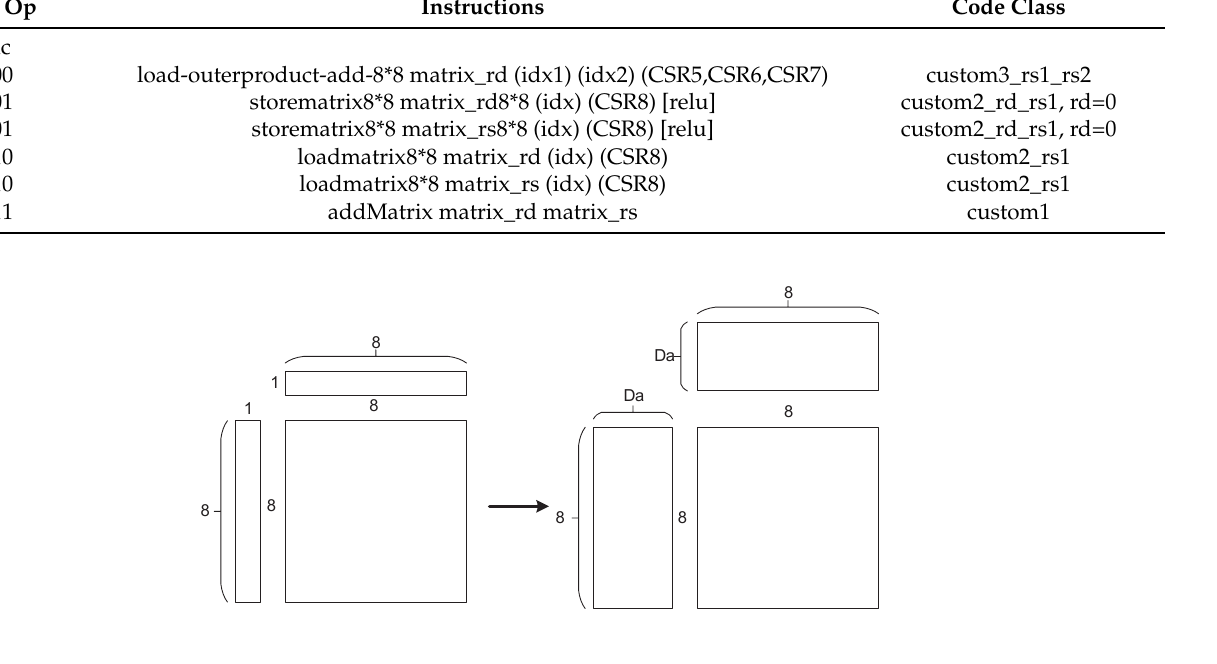
Figure 19. The difference between traditional matrix instructions and GPGCN matrix